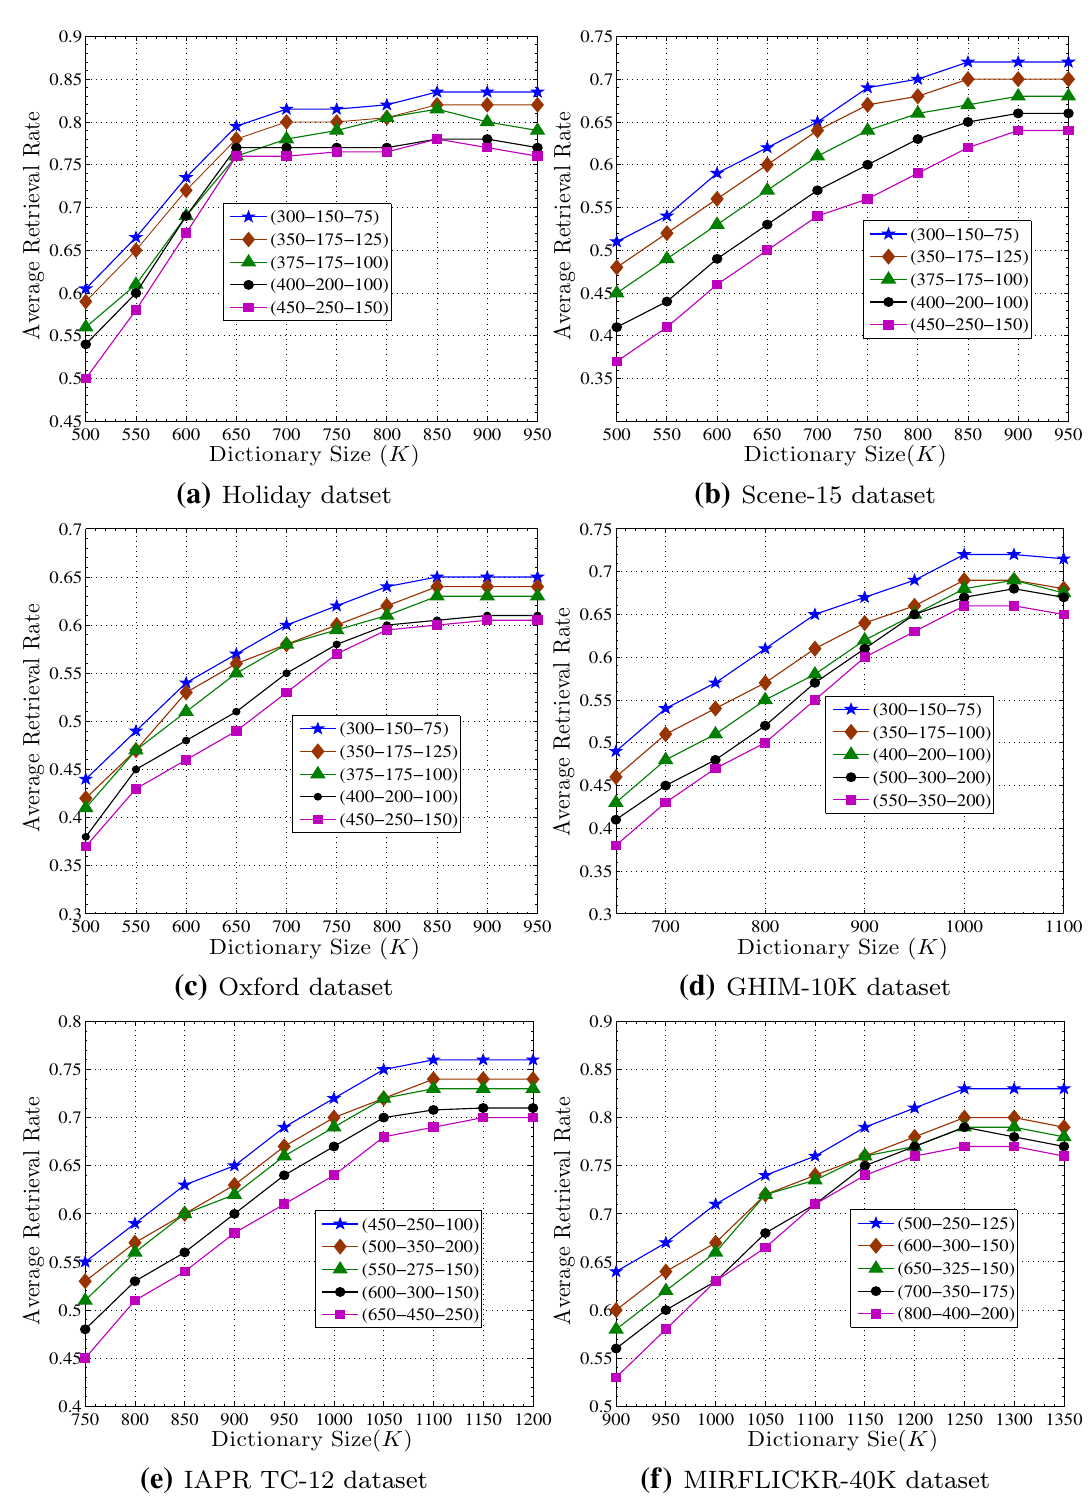
Fig. 9 Average retrieval rate obtained by the proposed HDLA model for various combinations of visual dictionary sizes ( K ) and hidden layer configurations. a Holiday datset. b Scene-15 dataset. c Oxford dataset. d GHIM-10K dataset. e IAPR TC-12 dataset. f MIRFLICKR-40K